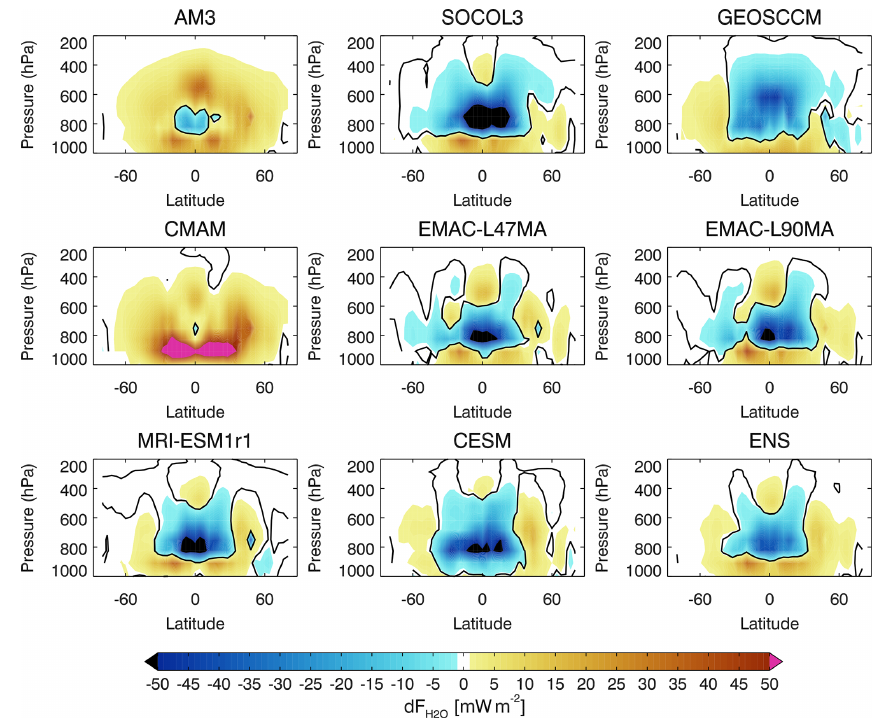
Figure 6. Vertical resolved H 2 O radiative bias. The black curves are the zero